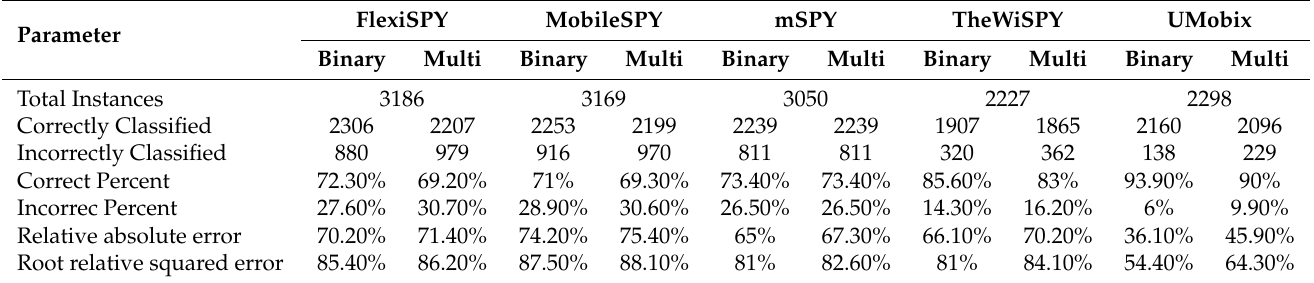
Table 11. Classification